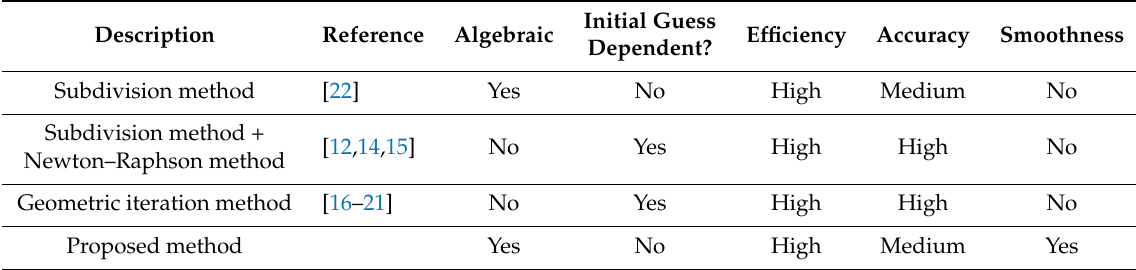
Table 1. Comparison of methods used for point projection in